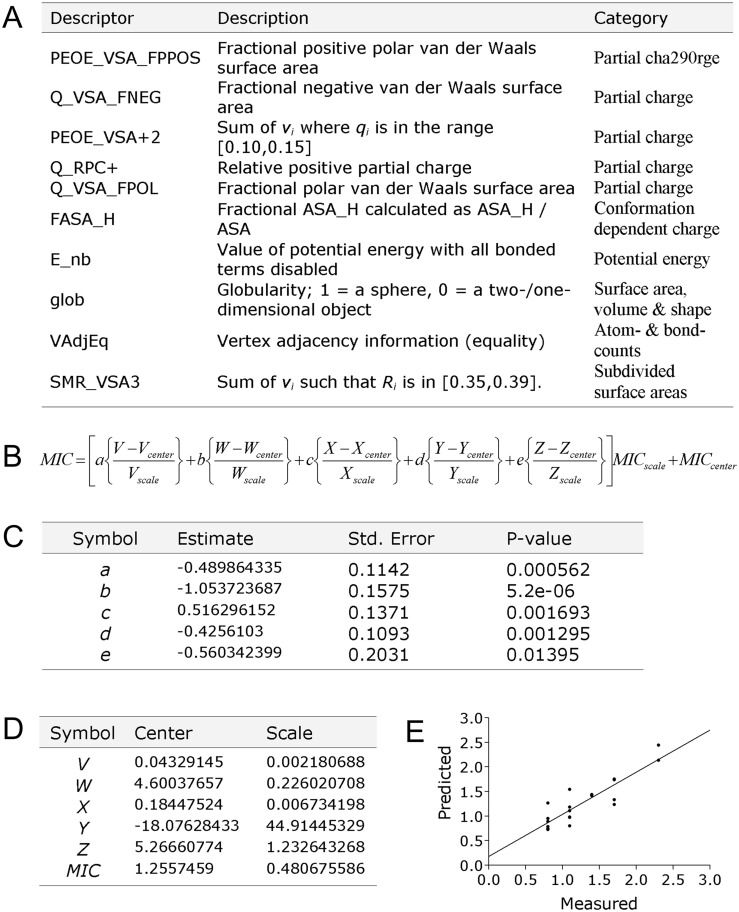
Model for predicting peptoid antimicrobial activity against Gram-negative E. coli.(a) gives an overview of the ten descriptors contributing the most to the predictive model. (b) gives the equation for calculating the predicted MIC (log10[MIC molar]) activity for any given peptoid, using the products of the descriptors in given as V, W, X, Y and Z, being (PEOE_VSA_FPPOS x Q_VSA_FNEG), (PEOE_VSA_plus2 x Q_RPC_plus), (Q_VSA_FPOL x FASA_H), (E_nb x glob) and (VAdjEq x SMR_VSA3), respectively (calculated separately for the specific peptoid). (c) The equation uses factors a, b, c, d and e, estimated contribution for each of the descriptor product elements, the accuracy and preciseness for a, b, c, d and e are indicated with standard error and p-values, and (d) the constant factors for centering and scaling of V, W, X, Y, Z and the MIC activities (forming the basis for the predictive model). (e) Illustrates predicted and measured are log(MIC in molar) for the peptoids in the generated QSAR solution, using a 10x cross-validated model (RCV = 0,8892 and RCV2 = 0,7907).